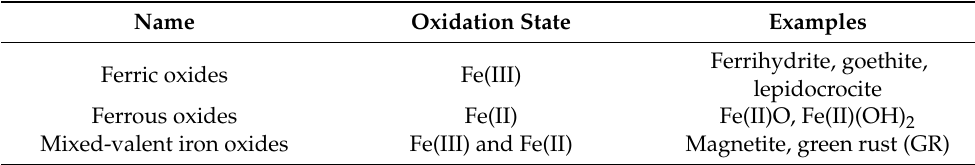
Table 4. Most common and major groups of Iron-oxide based on